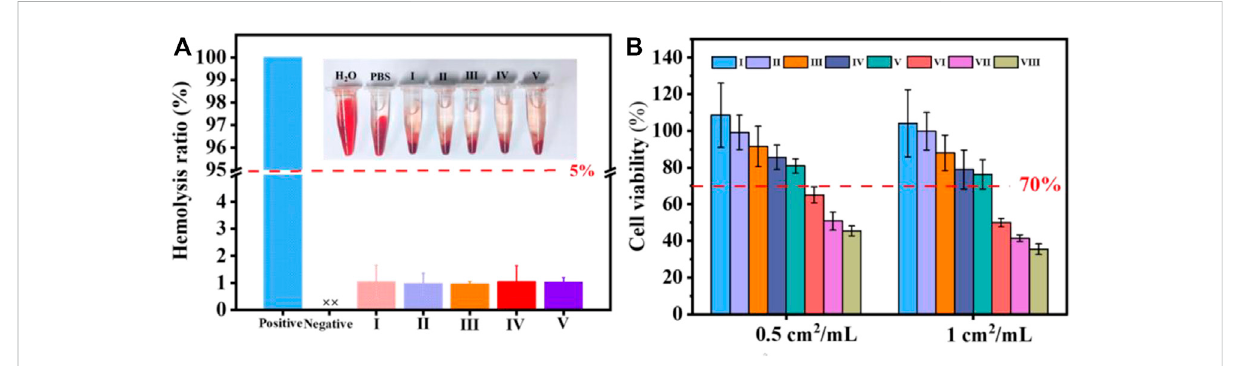
FIGURE 6 (A) Hemolysis of coated cotton fabric against erythrocyte cells; (B) cell viability with or without coated cotton fabric extracts treatments. I) cotton, II) cotton-SD, III) cotton-SD-PHMG 1 , IV) cotton-SD-PHMG 5 , V) cotton-SD-PHMG 10 , VI) uncrosslinked-cotton-SD-PHMG 1 ,